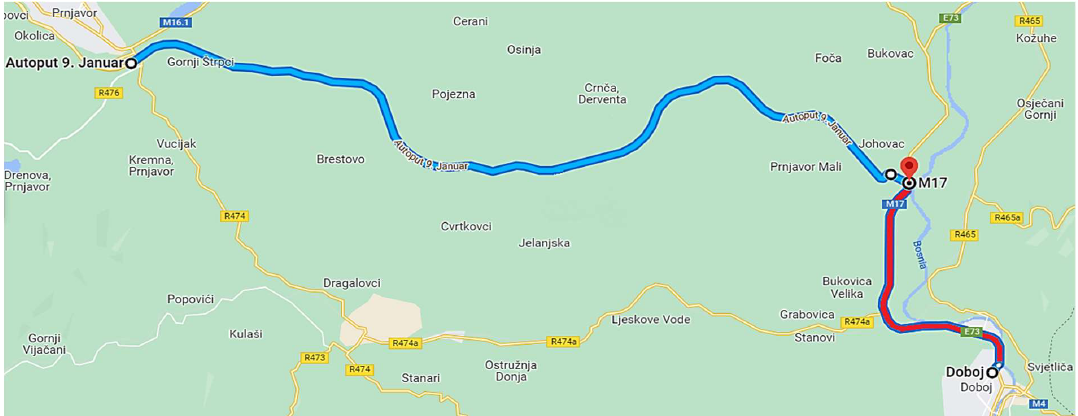
Figure 2. Observed road sections: P-J (blue) and J-D (red).